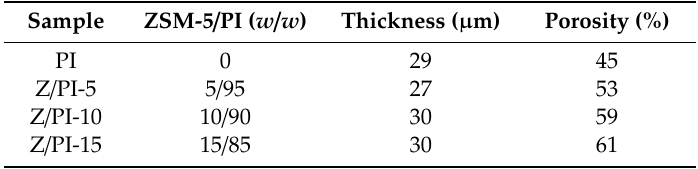
Table 1. The composition, thickness, and porosity of di ff erent separators.